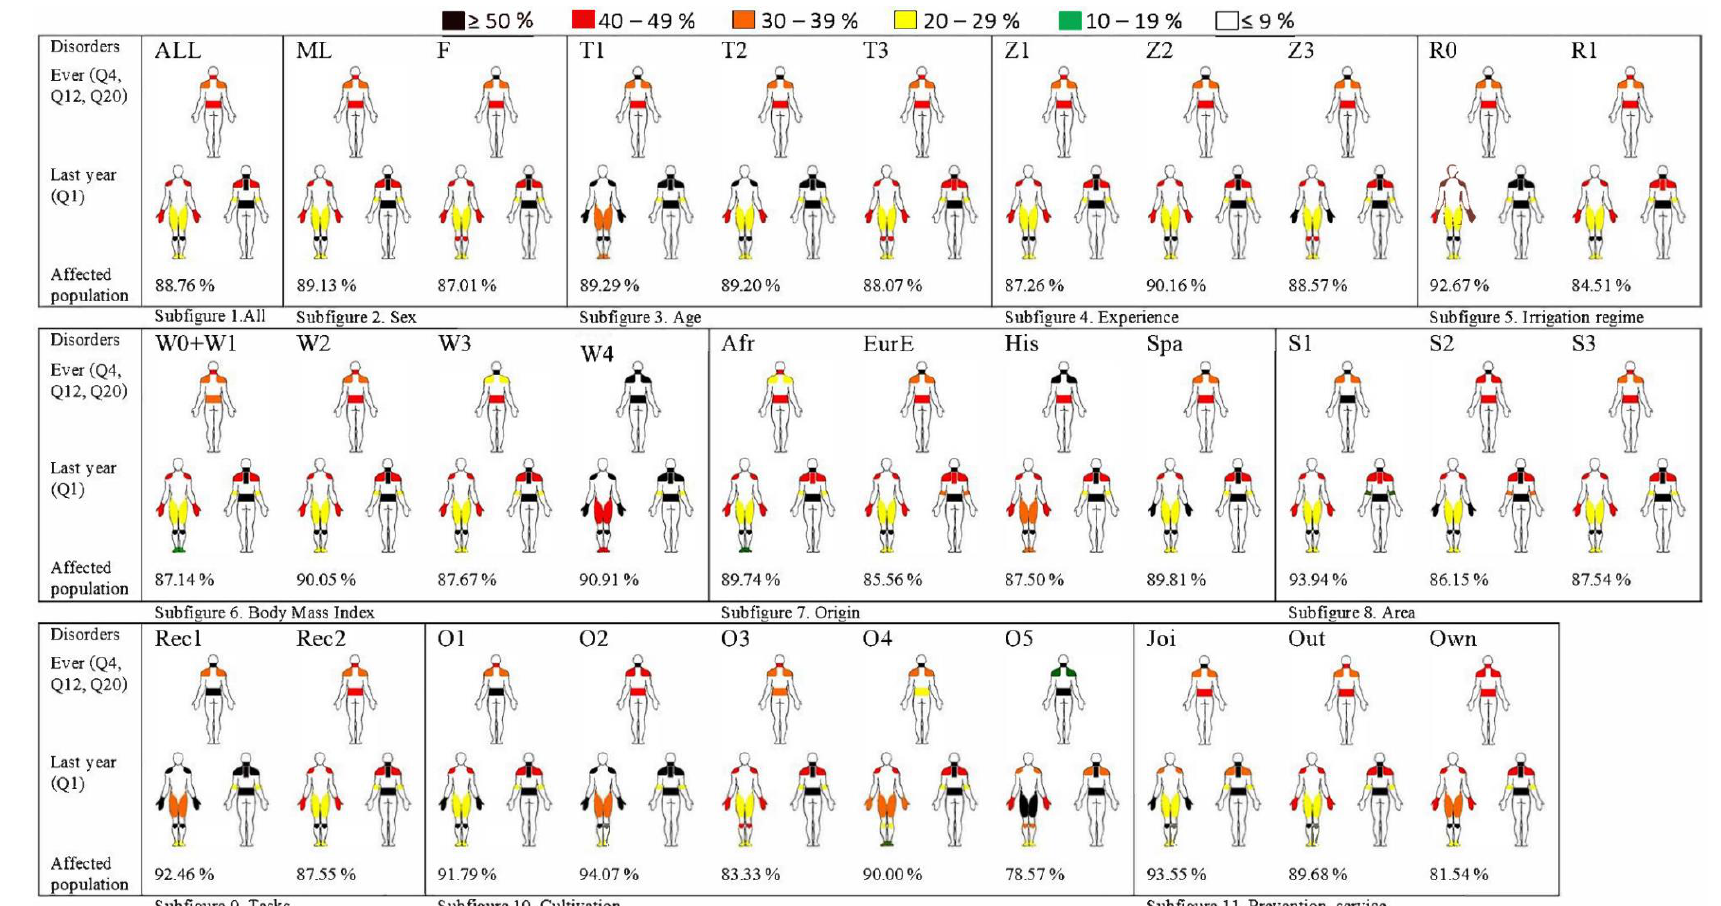
Figure 3. Ailments at some time during the last twelve months. Subfigure 1: All; Subfigure 2: Sex; Subfigure 3: Age; Subfigure 4: Experience; Subfigure 5: Irrigation regime; Subfigure 6: Body Mass Index: Subfigure 7: Origin or nationality; Subfigure 8: Area; Subfigure 9: Tasks; Subfigure 10: Cultivation; Subfigure 11: Prevention service. Abbreviations: Please see Table 3 and Table A1—Appendix A.